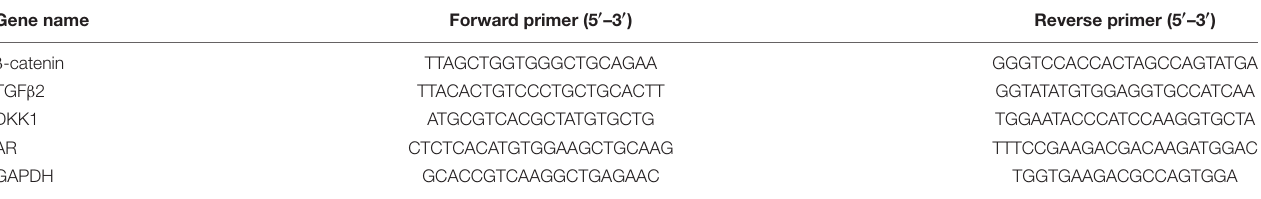
TABLE 1 | Primers used in the qPCR